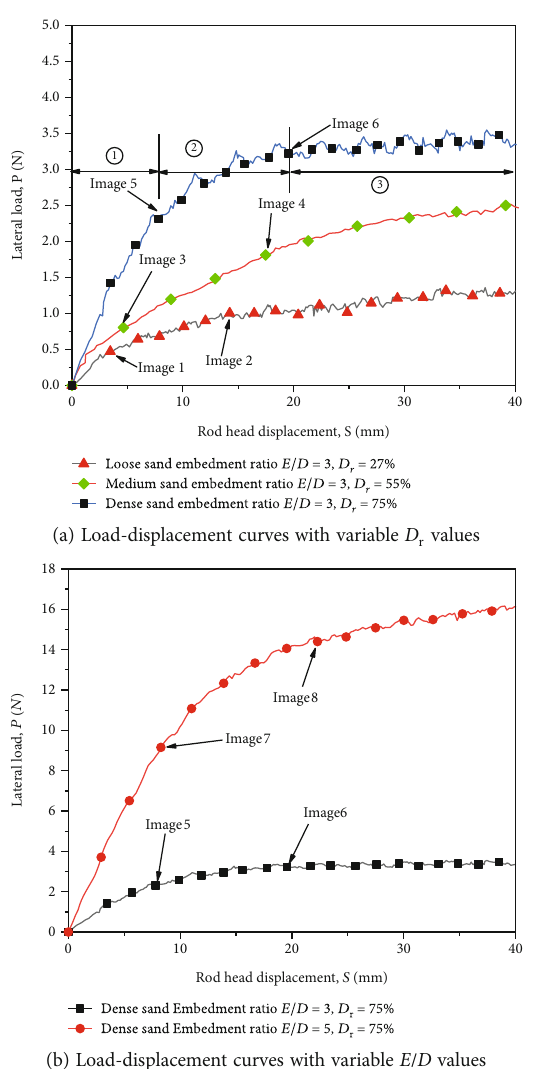
Figure 3: Relationship between lateral load and rod head displacement for di ff erent in fl uencing factors. Table 3: Information for images corresponding to points along the lateral load and displacement curve. Number Relative density and embedment ratio Image number Rod head displacement S (mm) Lateral load P